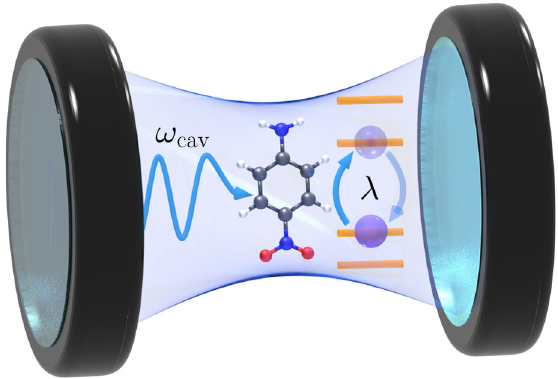
FIG. 1. Illustration of an optical cavity interacting with a